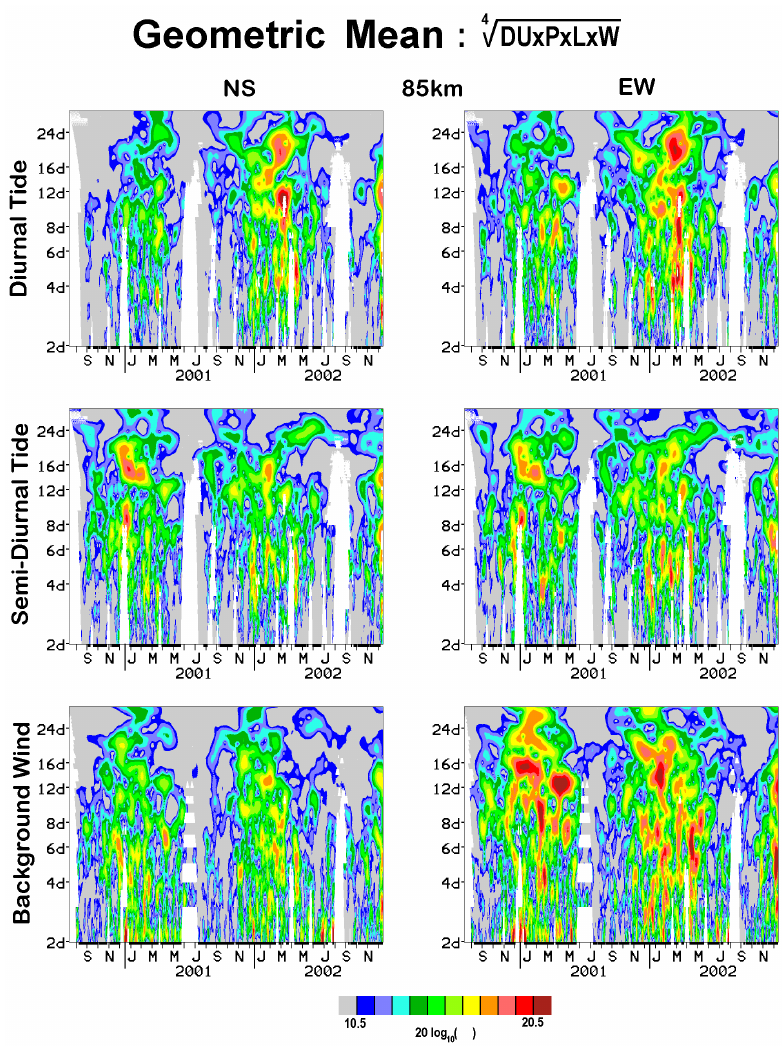
Fig. 6. Wavelet spectral plots: geometric means of the wavelets for the 85km daily winds, 12-h (semidiurnal) and 24-h (diurnal) tidal amplitudes (zonal EW, meridional NS) shown in Fig. 5 and the wavelets for the ozone (DU) values of TOMS for the same locations. The log is of the value of the term in the heading of the